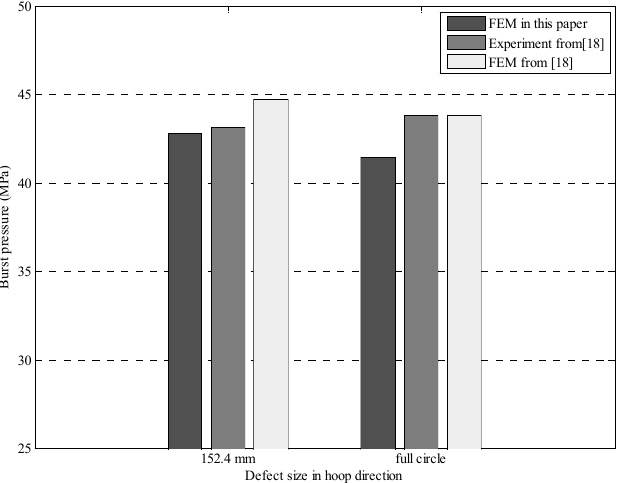
Figure 3. Validation of FE model for burst pressure.